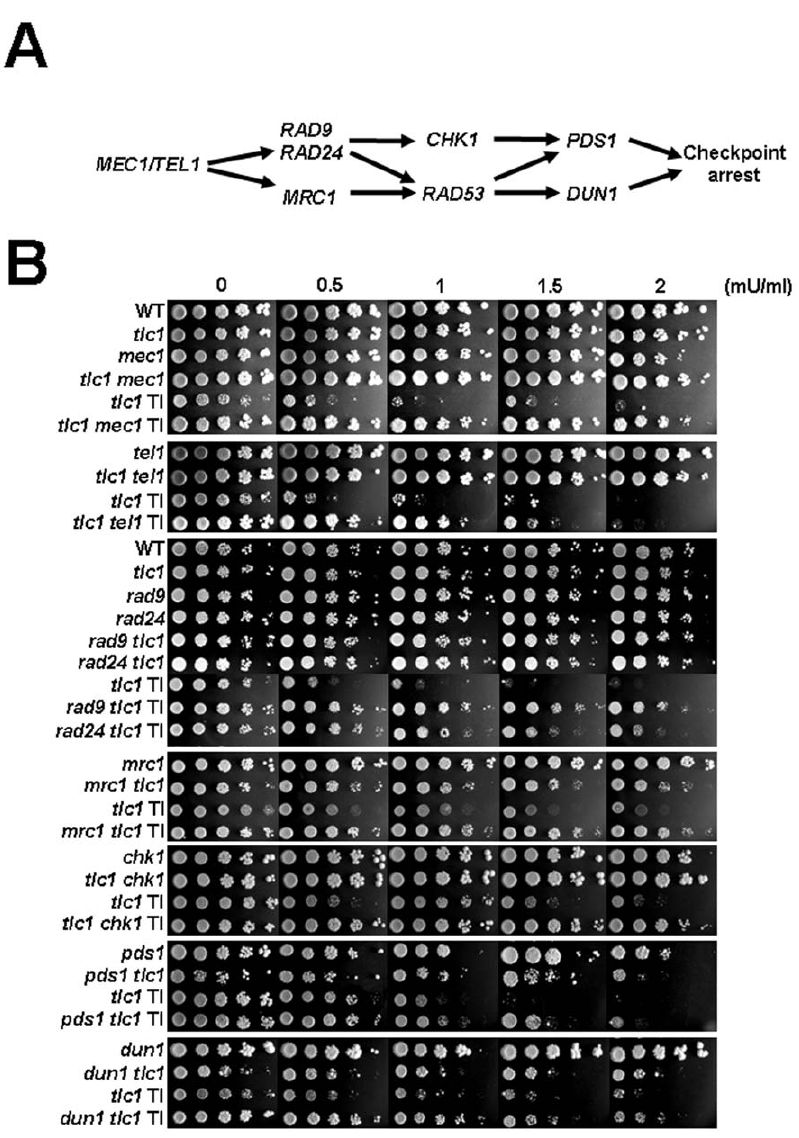
Figure 8. Type I sensitivity to bleomycin is in a largely checkpoint-dependent manner. ( A ) Signaling of MEC1 / TEL1 -regulated checkpoint pathway [56]. ( B ) Exponentially growing cells were five-fold serially diluted and spotted onto YPD plates containing bleomycin with indicated concentrations. Except for the plates shown in the last panel, which were incubated at 25 u C, all of the strains were incubated at 30 u C for three days. TI represents type I survivors derived from each mutant spore, and all the others are pre-senescent spore